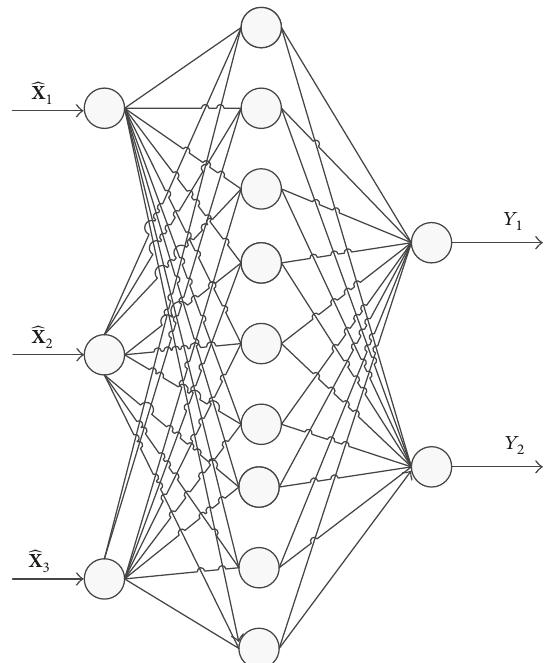
Figure 2: The principle of BP neural networks.